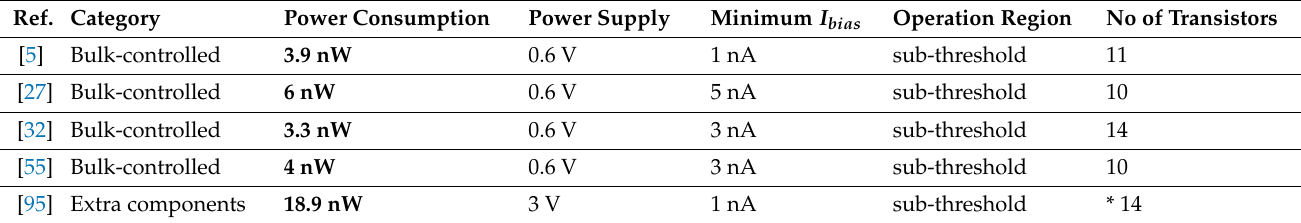
Table 11. Gaussian Function Circuits performance summary and comparison. *Additional current sources. Ref. Category